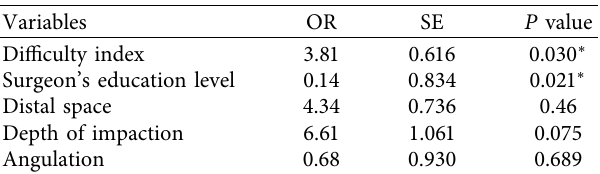
Table 2: Logistic regression analysis of predictors of inflation